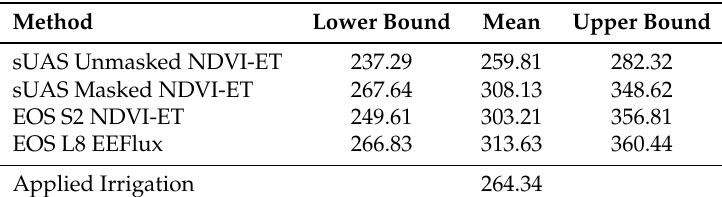
Table 3. Cumulative ET (10 3 m 3 ) with 95% confidence interval bounds, and applied irrigation, for 2018 growing